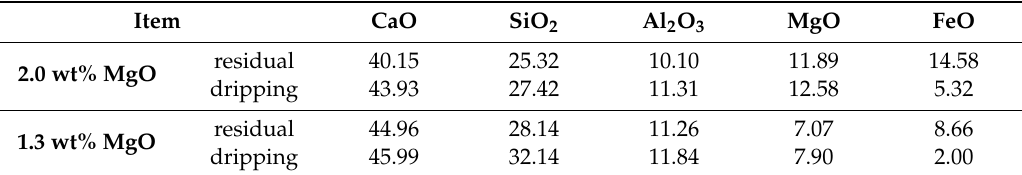
Table 8. Chemical compositions of dripping and residual slag [%].